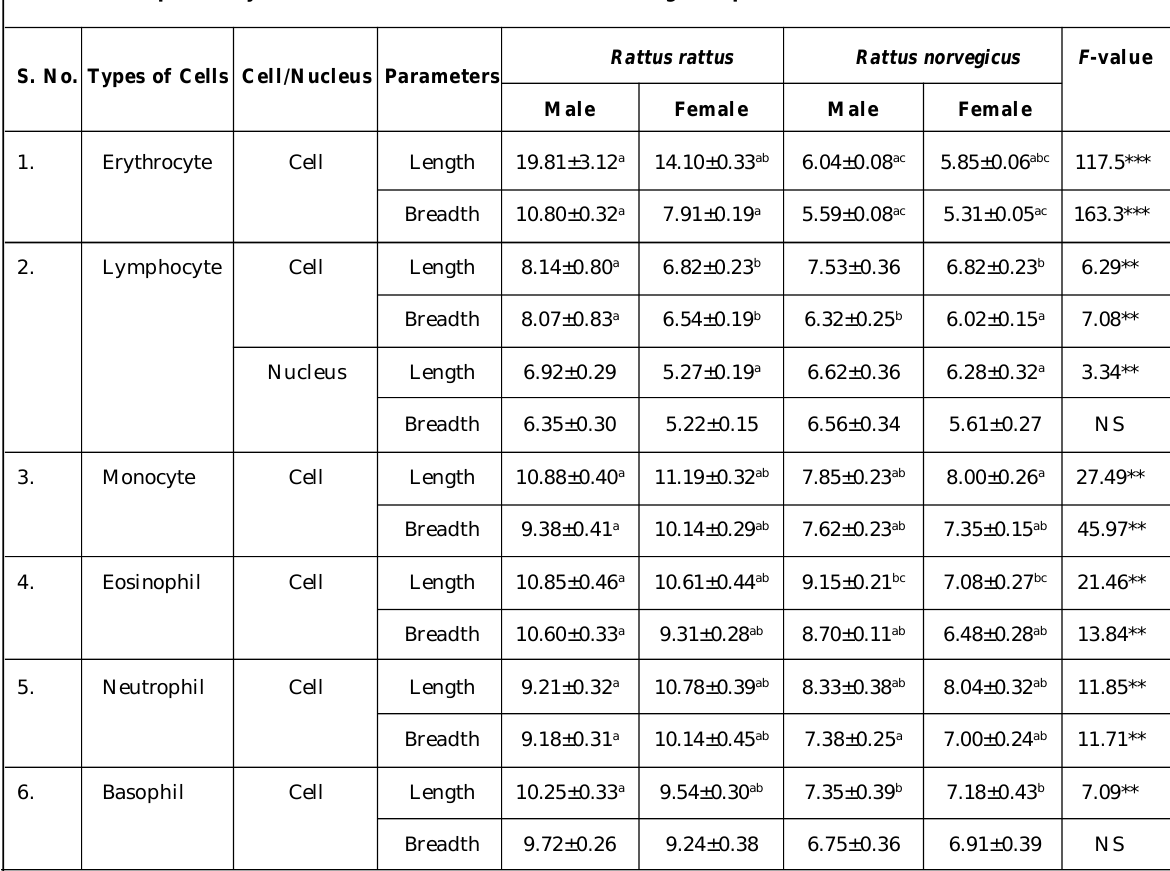
S. No. Types of Cells Cell/Nucleus